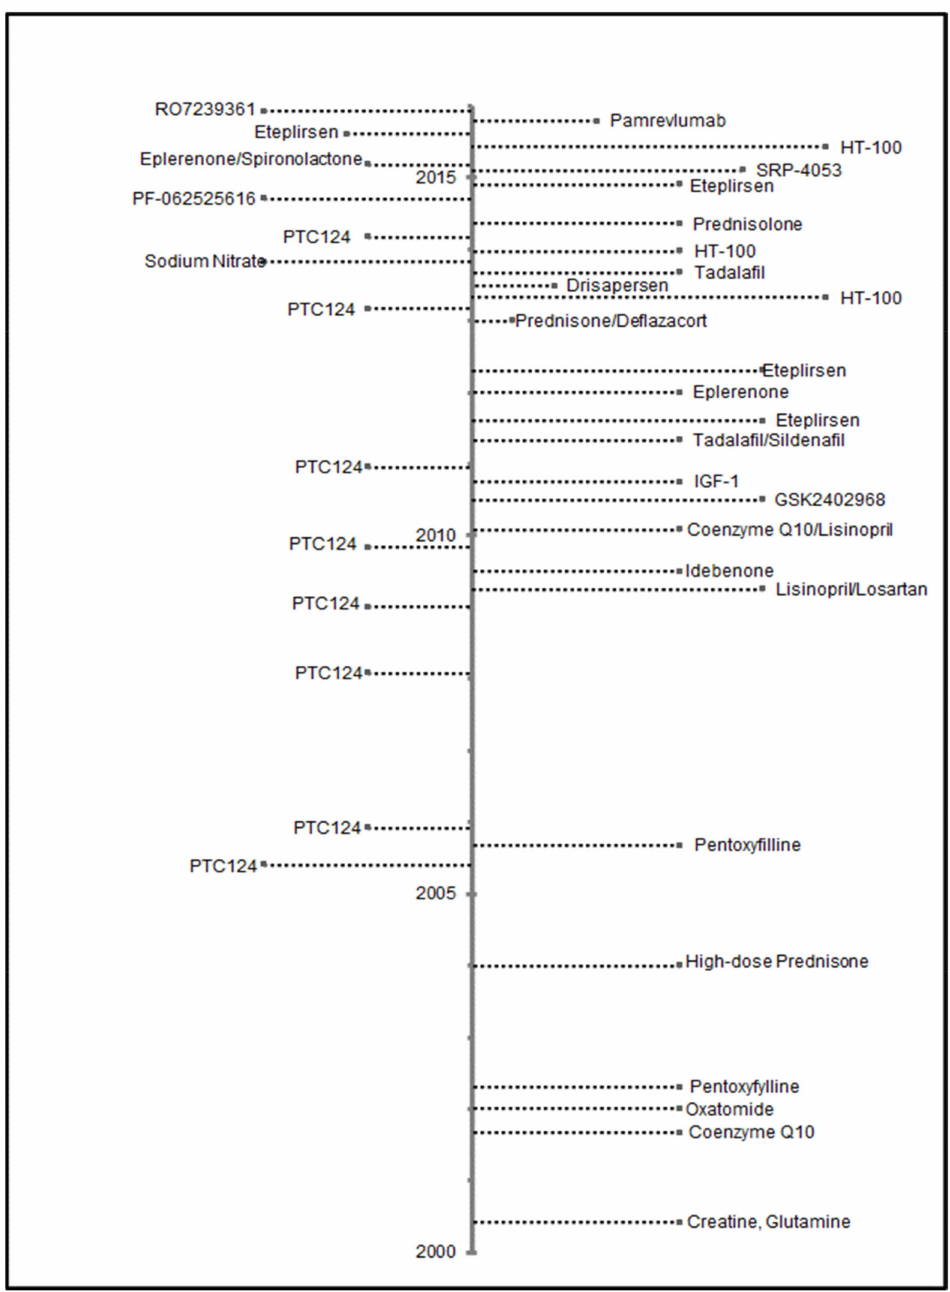
Figure 2. Dates of posting Phase 2 and 3 drug trials from ClinicalTrials.gov, using search criteria of Duchenne muscular dystrophy as disease; interventional studies as study type; and child (birth to 17 years) age. Trials were additionally limited to those occurring in the U.S. with a start date from 1 January 2000 to 31 December